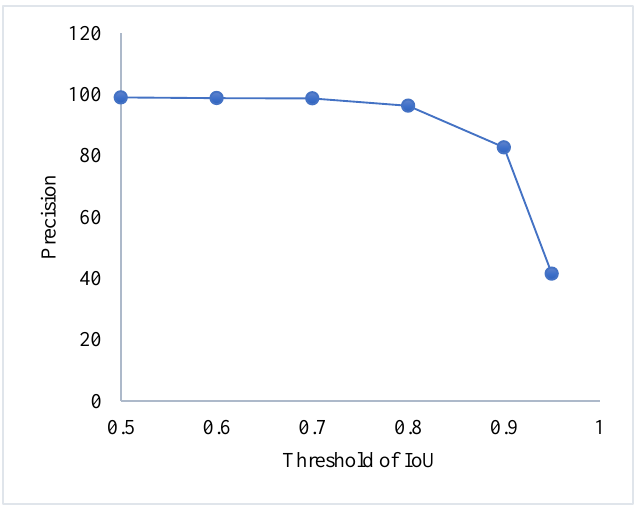
Figure 9 . Segmentation precision at IoU thresholds of 0.50 – 0.95 . Figure 9. Segmentation precision at IoU thresholds of 0.50–0.95.